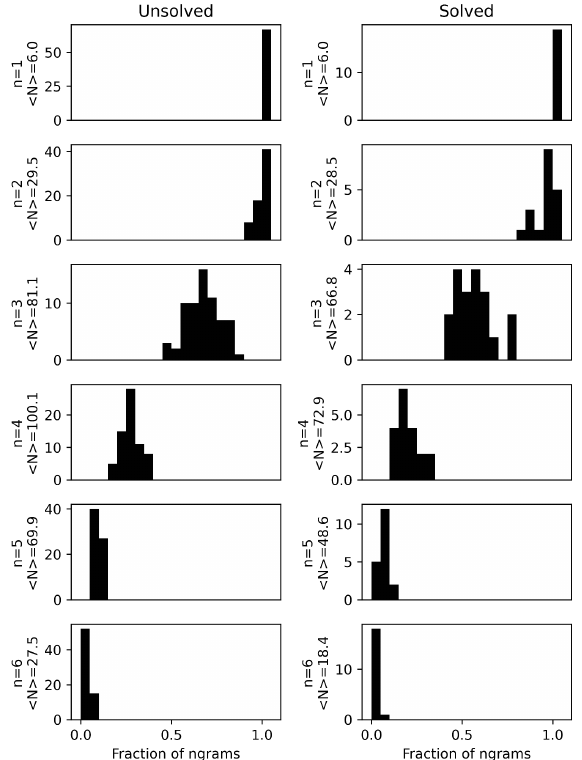
Figure 5. Consideration of n-grams (n = 1, 2, 3, 4, 5, 6) for 6- letter anagrams for (a) solved and (b) unsolved anagrams. For n = 2, there are 30 possible bigrams. For n = 3, there are 120 pos- sible trigrams. The number of distinct n-grams within each letter sequence is counted and presented here as